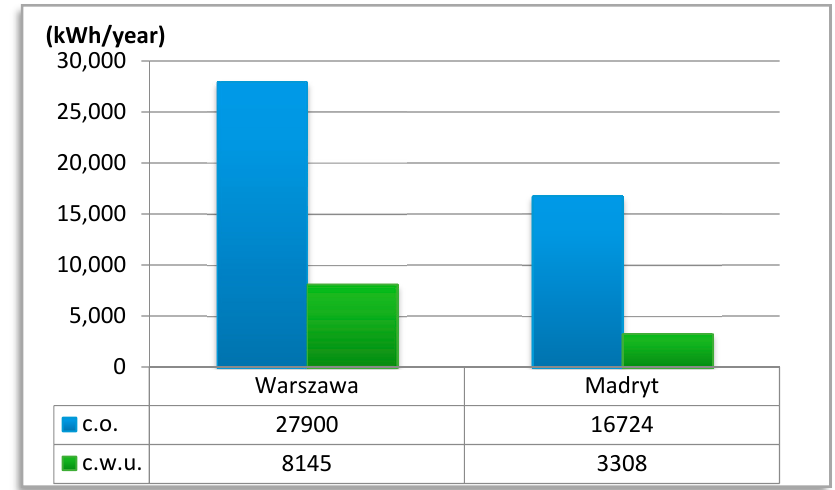
Figure 1. Demand for usable energy for heating and domestic hot water (DHW) preparation in Poland and Spain (based on